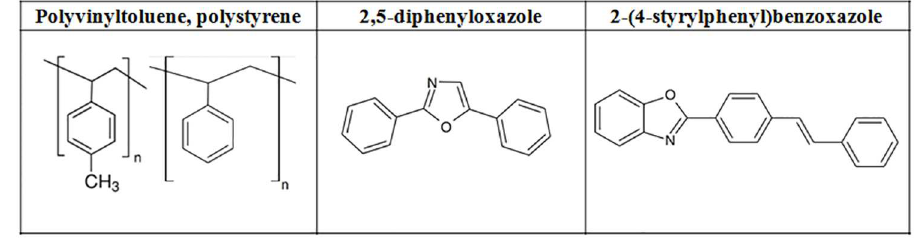
Fig 2. Components of the J-PET plastic scintillators.